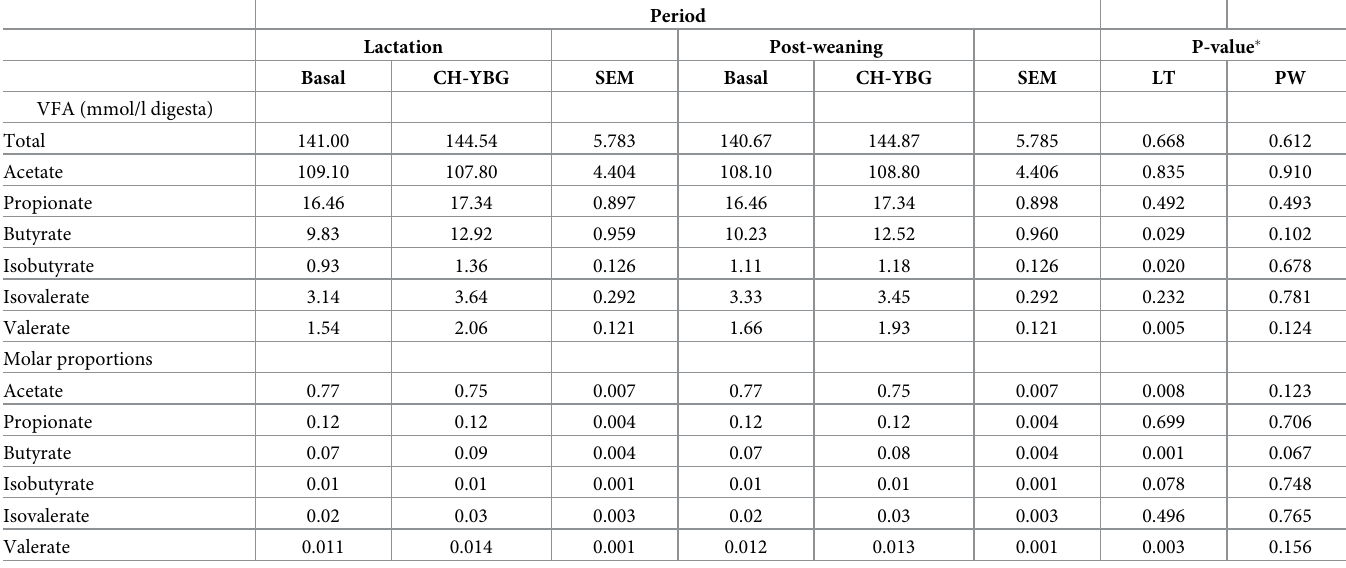
Table 11. Effect of supplementation of CH-YBG during gestation/lactation and/or post-weaning on total and molar proportions of volatile fatty acids (VFA) in colonic digesta. (least-square mean values with their standard error of